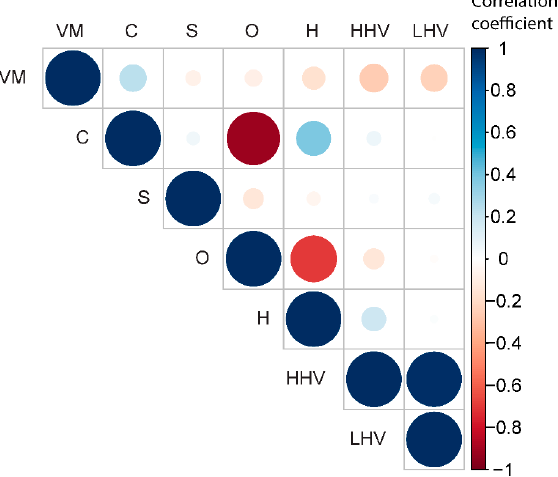
Figure 2. Correlation plot of observed values.